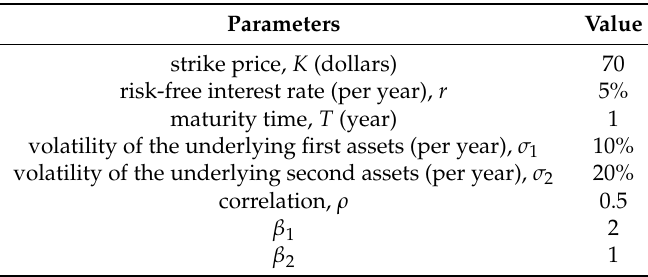
Table 1. Parameters of the numerical